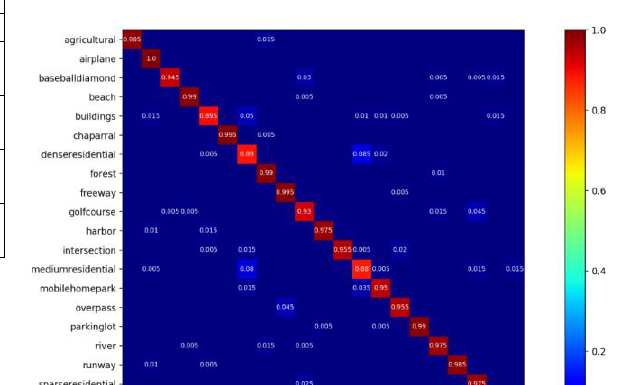
Figure 7 The confusion matrix of VGG16 model's classification result on UC-Merced dataset.